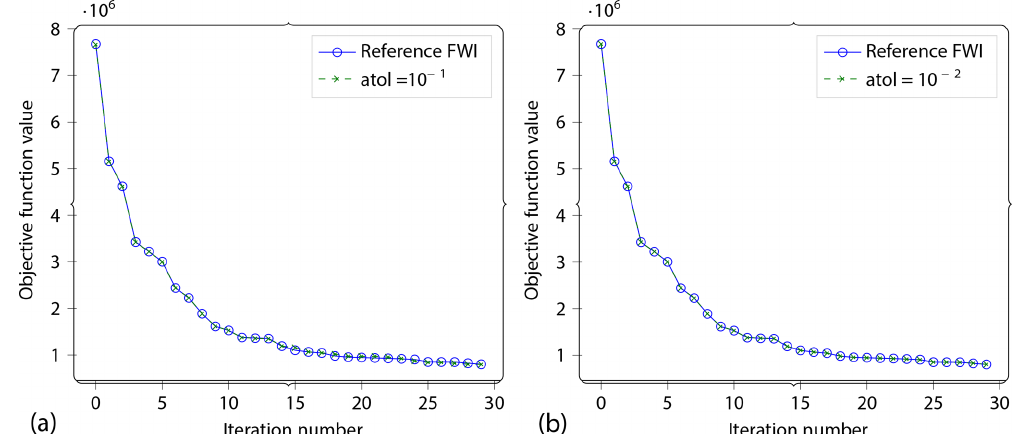
Figure 16. Convergence. As the last experiment, we run complete FWI to convergence (up to max 30 iterations). Here we show the conver- gence profiles for atol = 10 − 1 (a) and atol = 10 − 2 (b) vs. the reference problem. The reference curve is so closely followed by the lossy curve that the reference curve is hidden behind it.